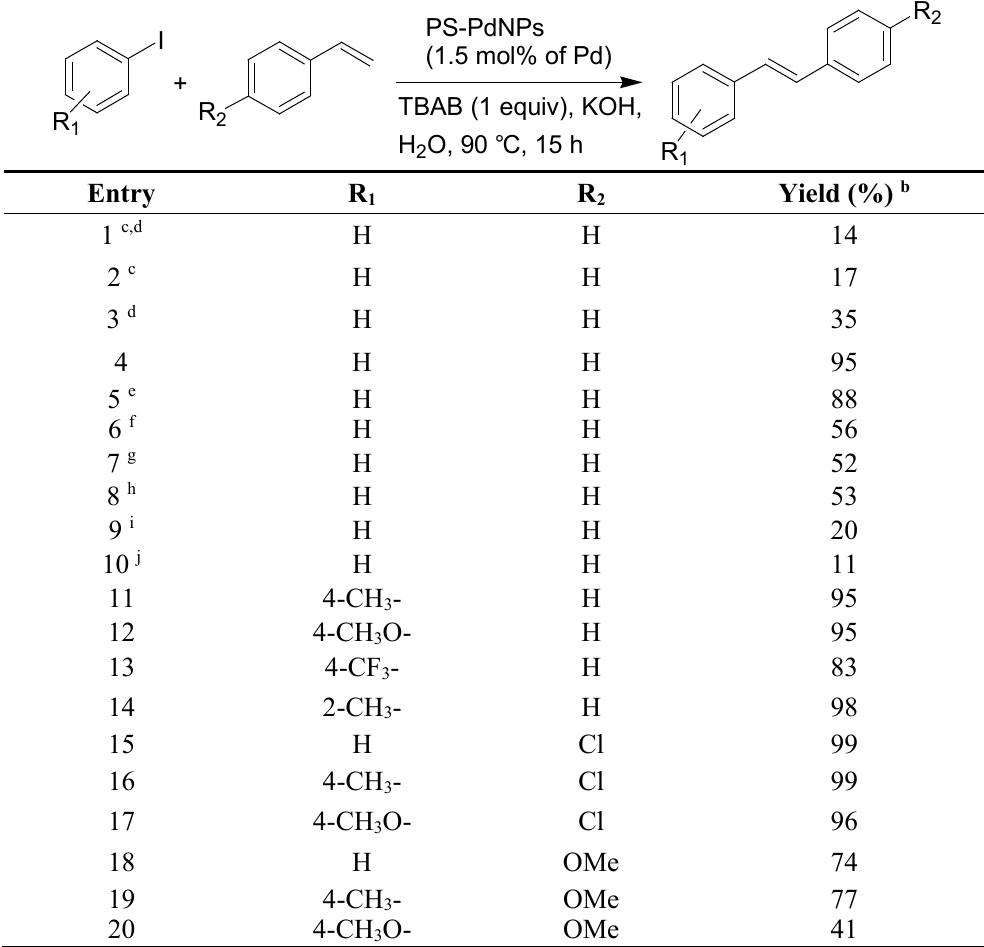
Table 2. Heck reaction of aryl iodide with styrene a